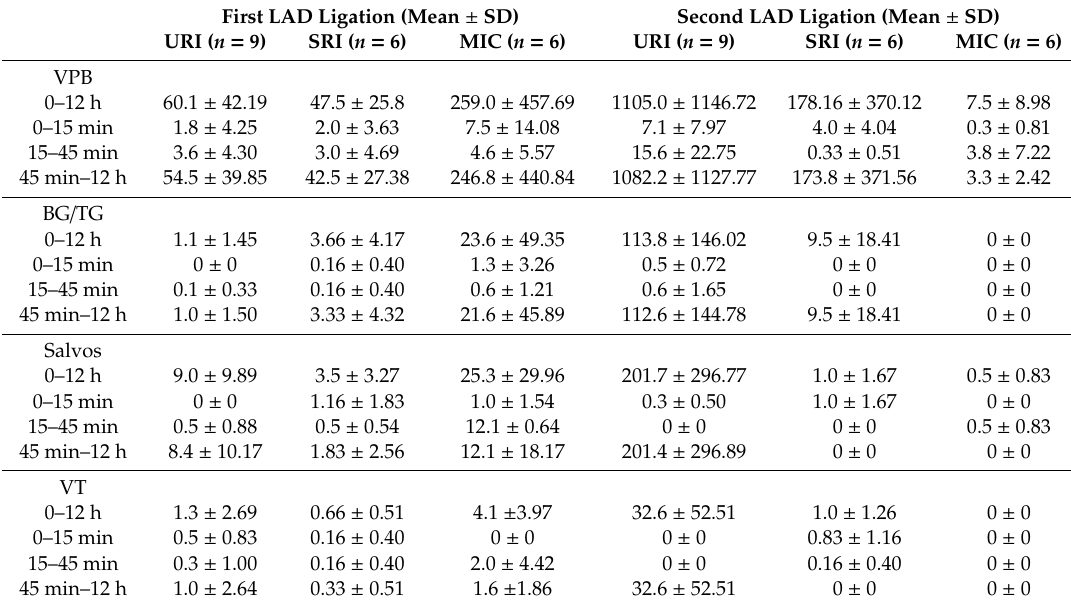
Table 1. Developed ventricular arrhythmias at various time